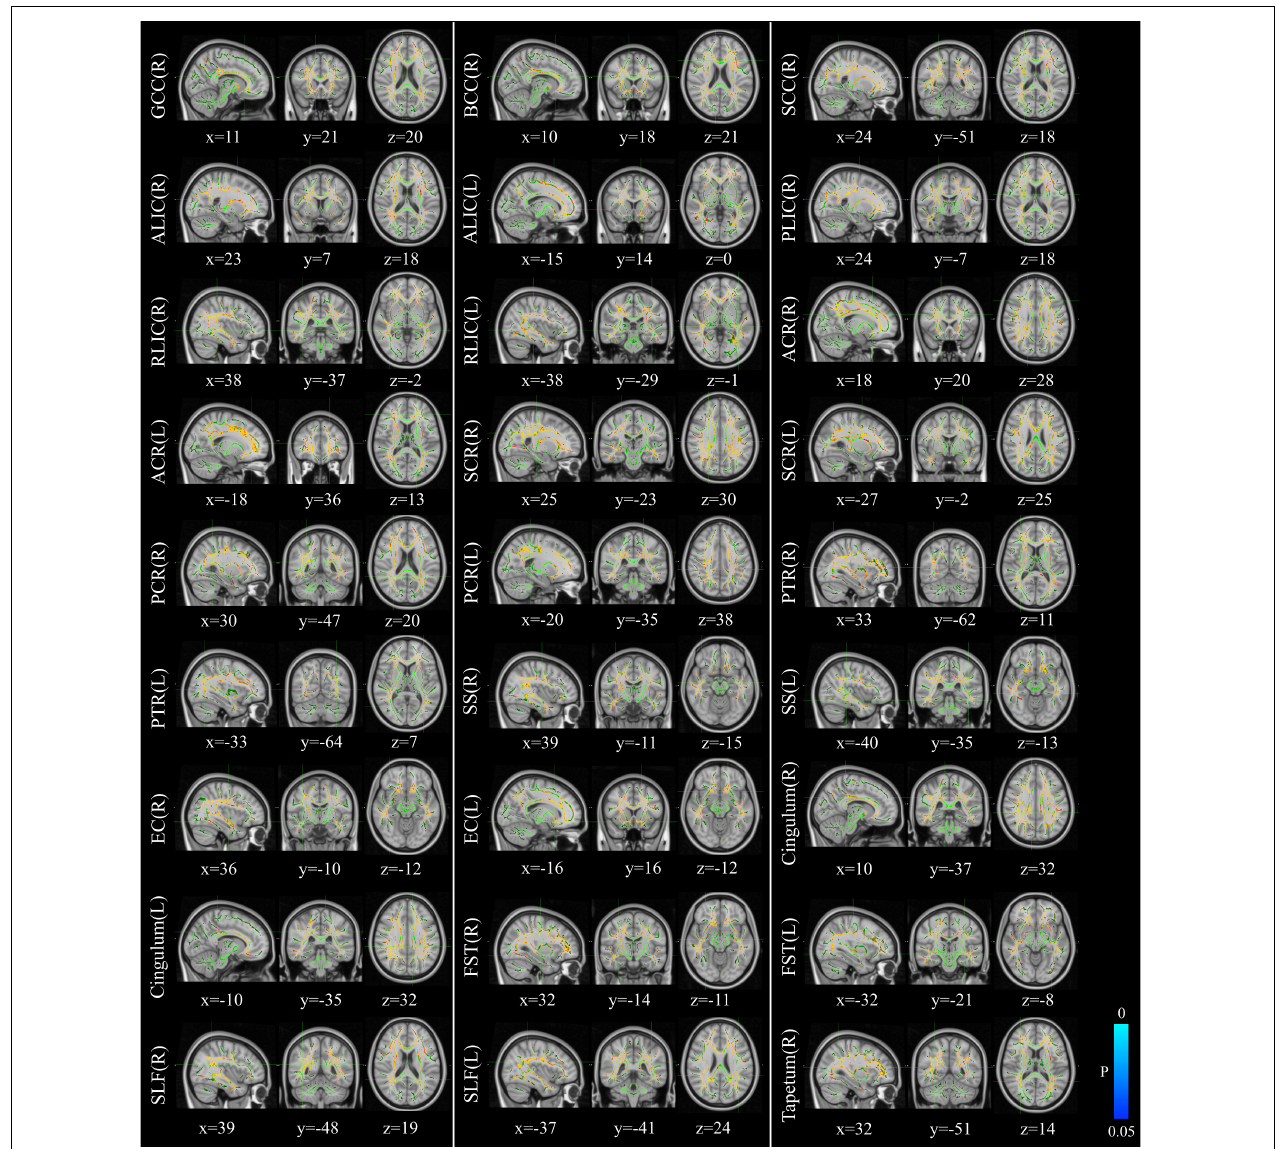
FIGURE 3 | Distribution map of the mean diffusion (MD) value that was significantly higher in the patients group compared with the control group based on the TBSS analysis (red-yellow). Statistical images ( p FWE < 0.05 corrected for multiple comparisons) were overlapped onto the mean of the skeleton (green) and the MNI152 template (gray-scale) for visualization. TBSS, tract-based spatial statistics; GCC, genu of corpus callosum; BCC, body of corpus callosum; SCC, splenium of corpus callosum; ALIC, anterior limb of internal capsule; PLIC, posterior limb of internal capsule; RLIC, retrolenticular part of internal capsule; ACR, anterior corona radiate; SCR, superior corona radiate; PCR, posterior corona radiate; PTR, posterior thalamic radiation; SS, sagittal stratum; EC, external capsule; FST, fornix/stria terminalis; SLF, superior longitudinal